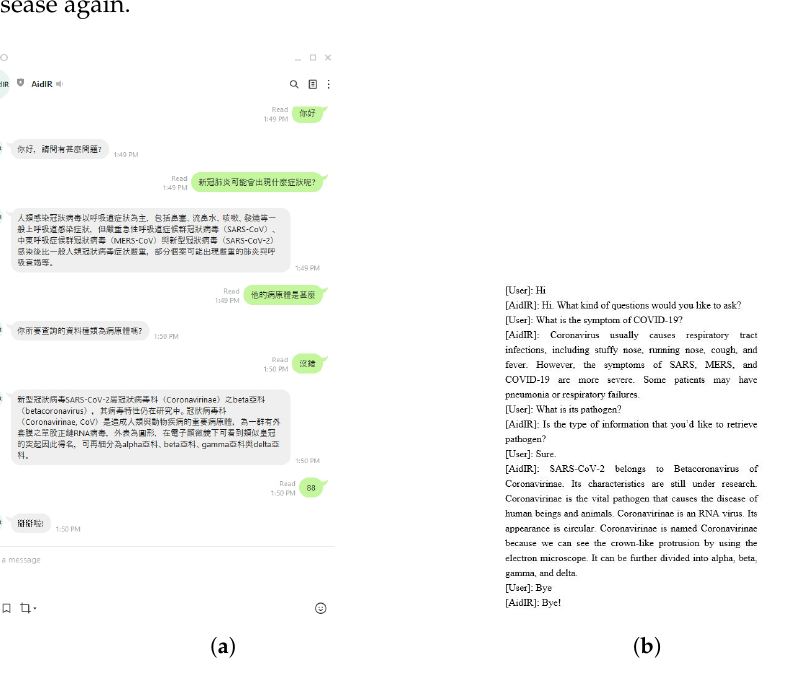
Figure 14. User asks many questions related to one disease: ( a ) original dialog; and ( b ) dialog in